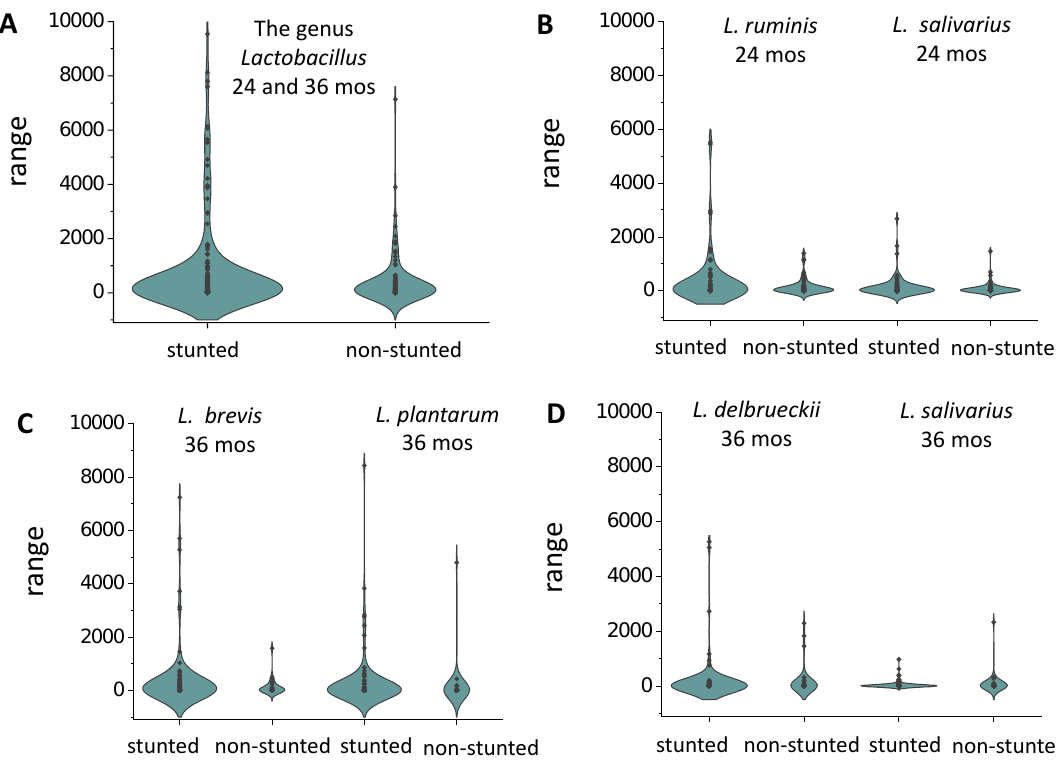
Figure 4. Violin plots showing the abundance of Lactobacillus genus and species in stunted and nonstunted children expressed in sequence reads in the gut microbiota of 140 children from Kabale and Kisoro, southwestern Uganda, at 20–24 months ( n stunted = 77) and 36 months ( n stunted = 104).